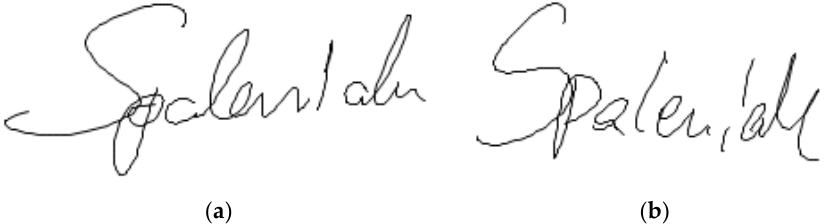
Figure 6. Image ( a ) depicts the first participant’s signature, while ( b ) shows the other one’s forgery attempt.